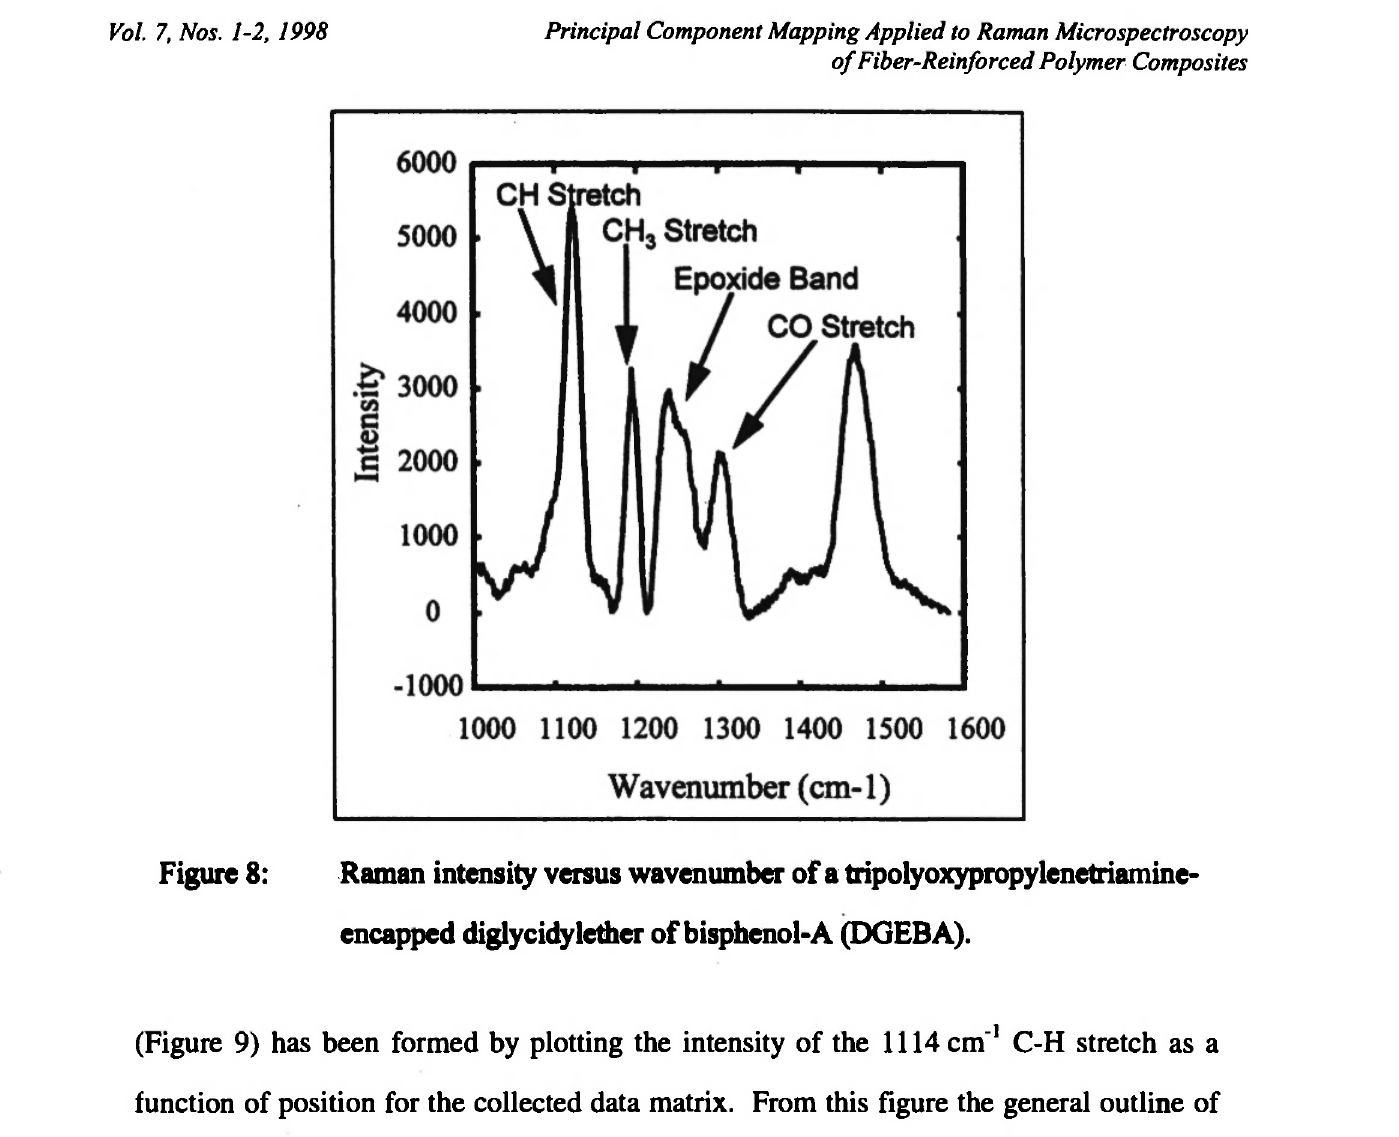
Figure 8: Raman intensity versus wavenumber of a tripolyoxypropylenetriamine- encapped diglycidylether of bisphenol-A